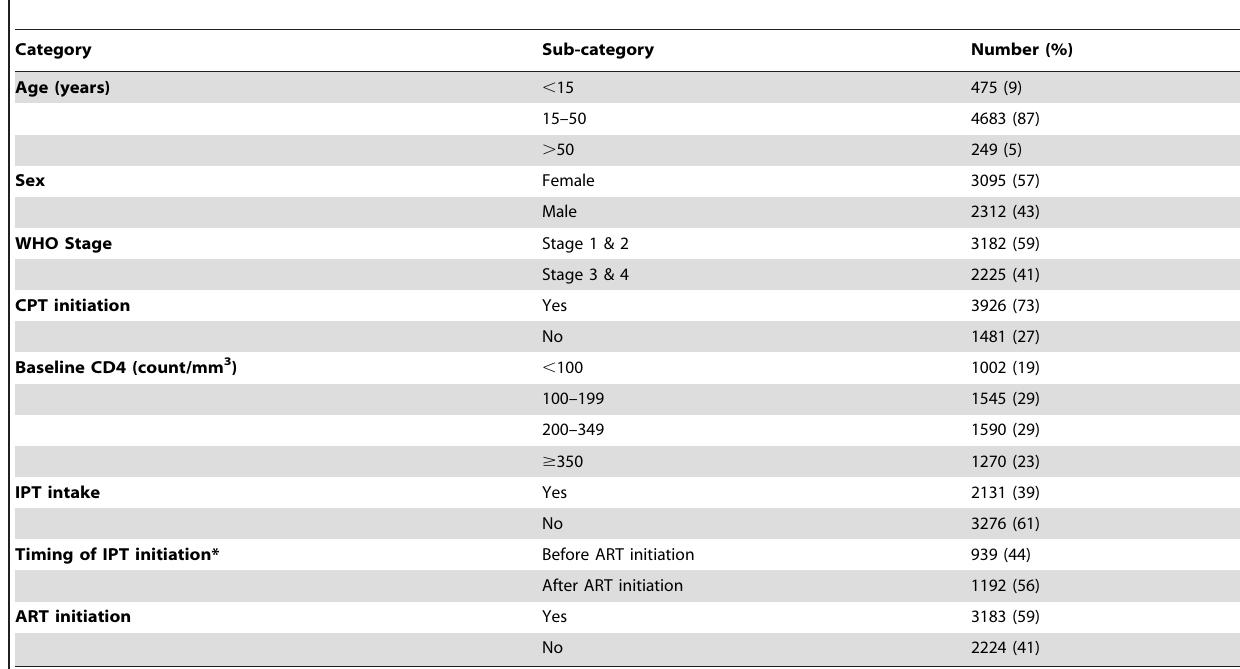
Table 1. Characteristics of HIV infected patients in chronic HIV care in SNNP region, Ethiopia, September 2007 to August 2010.